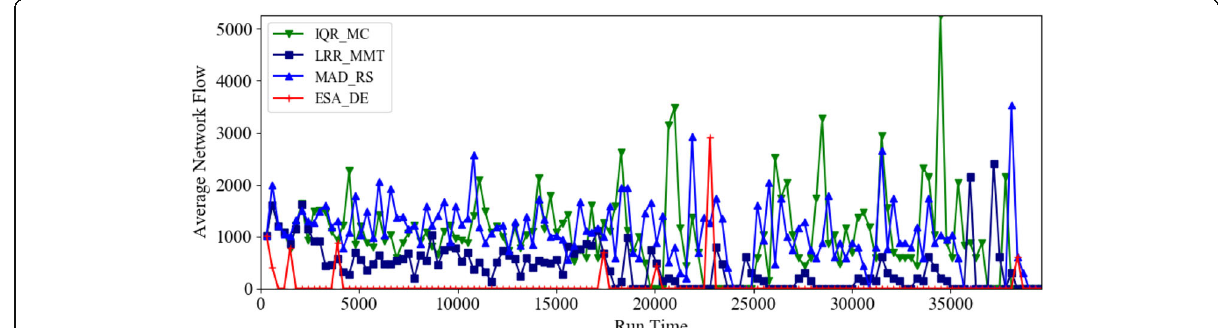
Fig. 11 Average network flow at different time